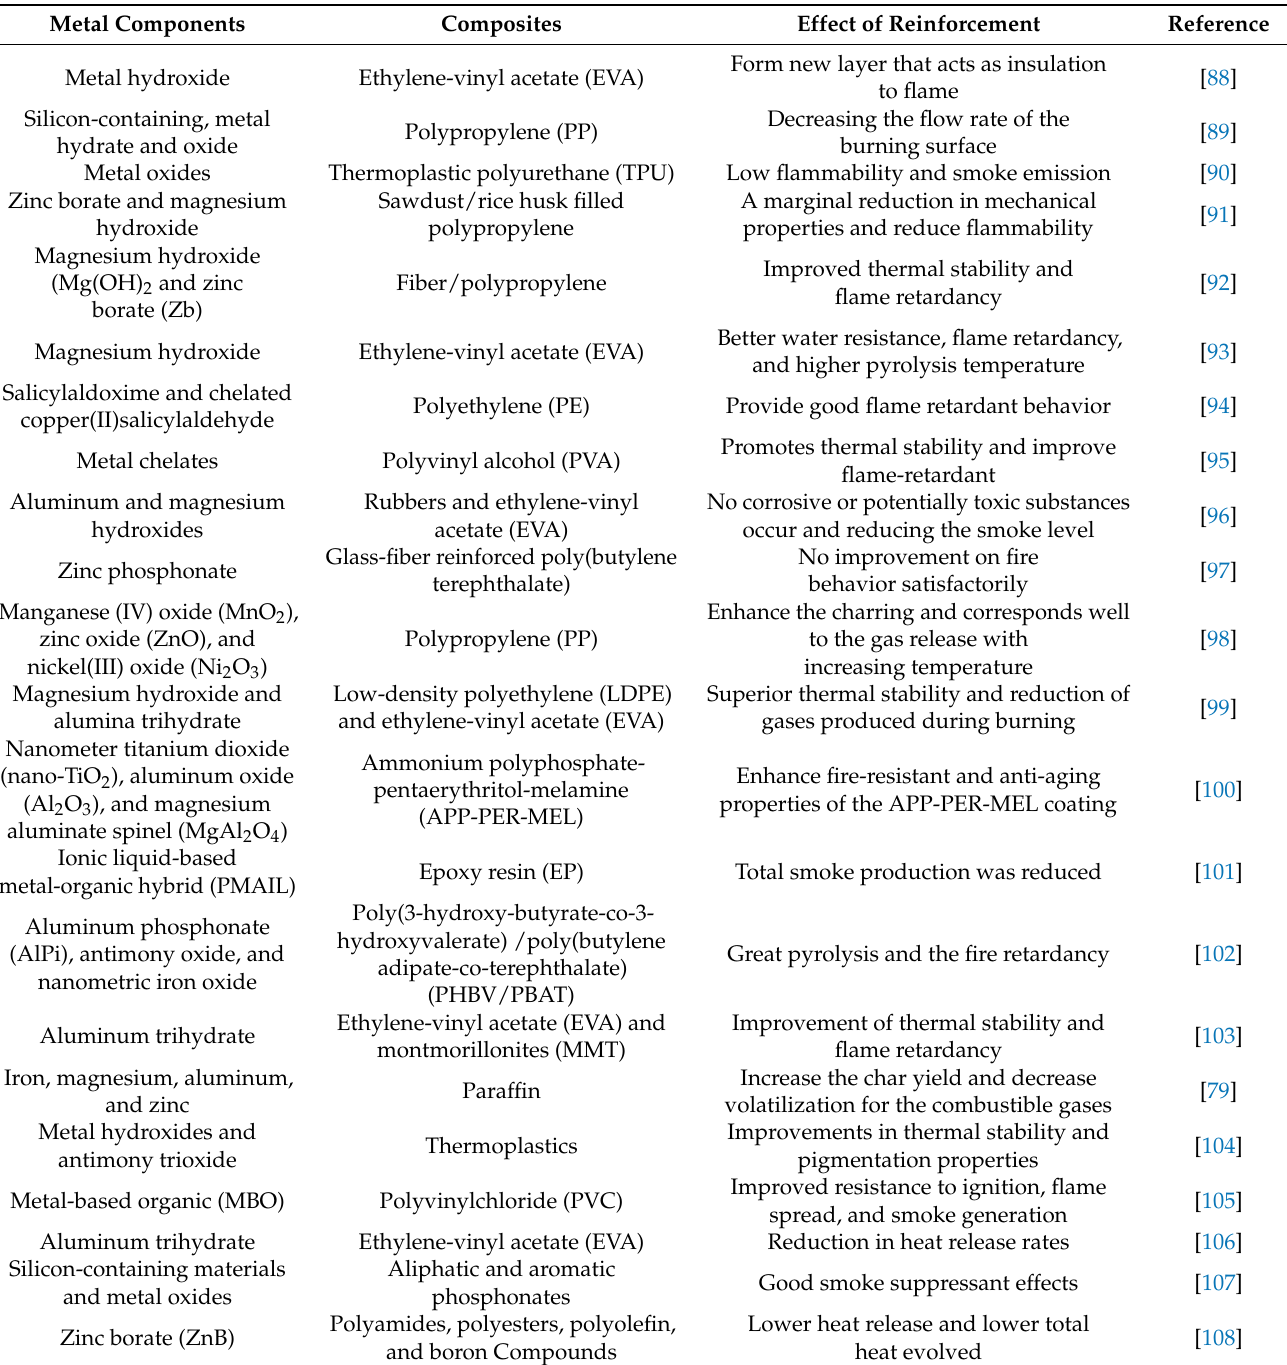
Table 2 summarizes metal particle functions as FR additives in various composites. Table 2. Reported type for metal components of flame retardant on different types of